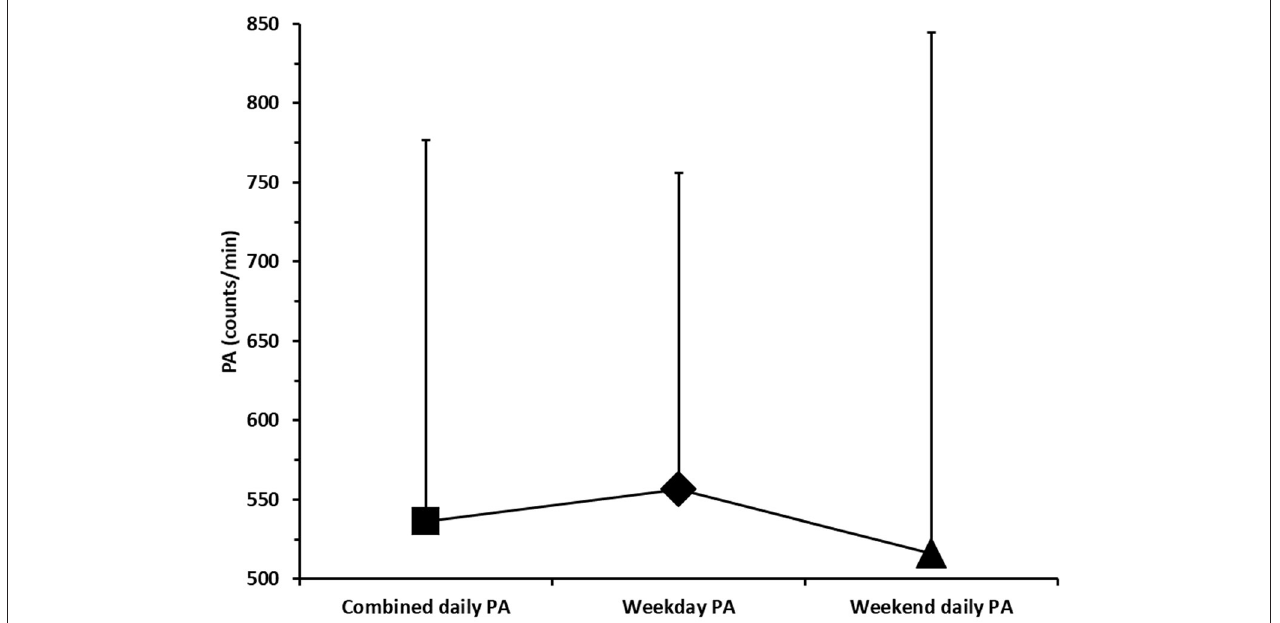
FIGURE 1 | Combined physical activity (PA), weekday PA, and weekend PA of adolescent school girls.